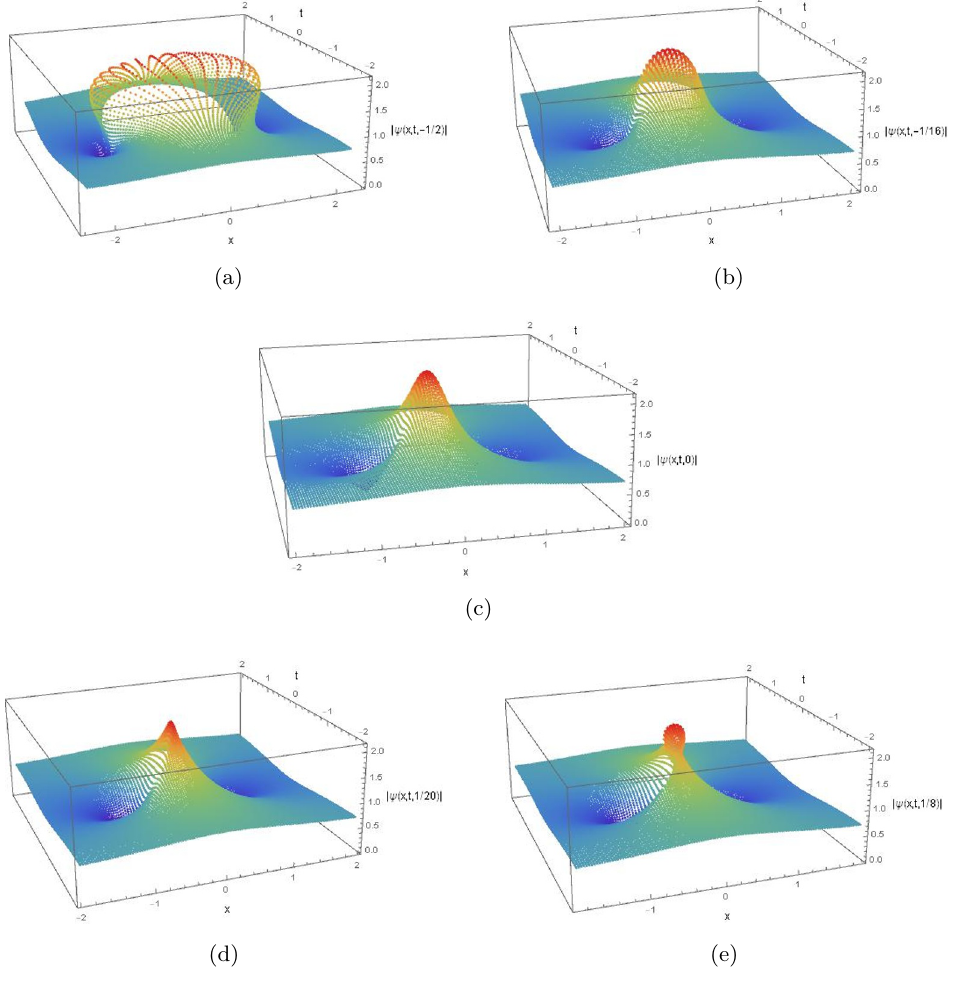
Figure 2 . The modulus of the T ¯ T -deformed Peregrine’s soliton solution ψ 0 ( x , τ ) for different values of τ . The parameters are chosen as follows: m = 1 and k = 1